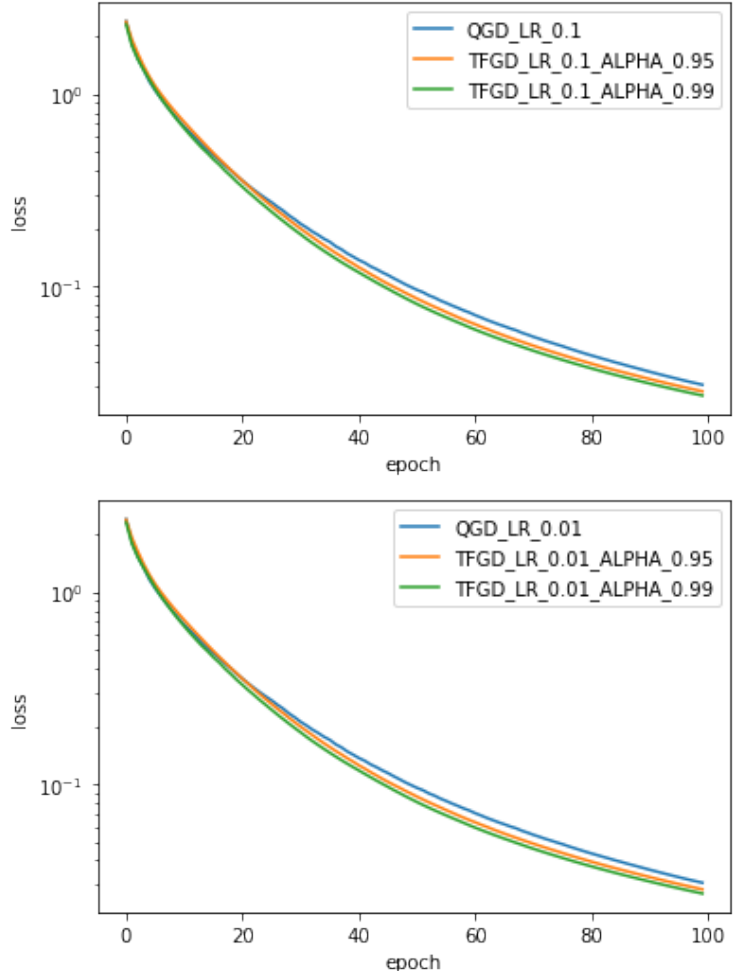
Figure 3. Comparison of loss effects for the learning rates η = 0.1 and η = 0.01, and the fractional order parameters α = 0.95,0.99, where QGD and TFGD stand for the general gradient descent and the time-fractional gradient descent,